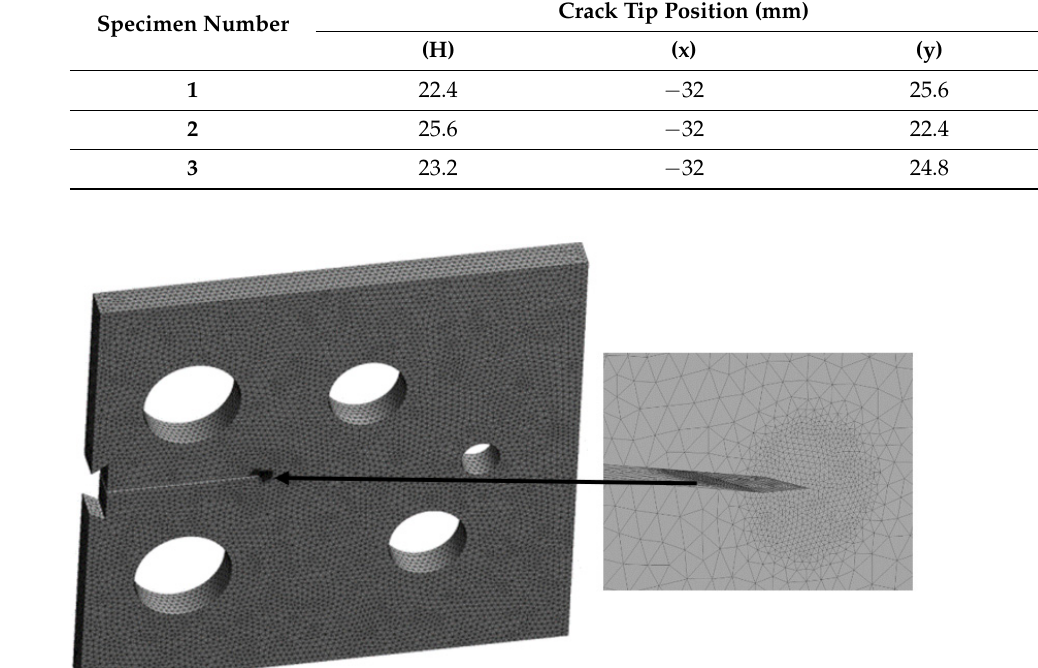
Figure 5. Specimen 2, crack propagation path ( a ) ANSYS results, ( b ) experimental results [46], and ( c ) numerical results [47] .